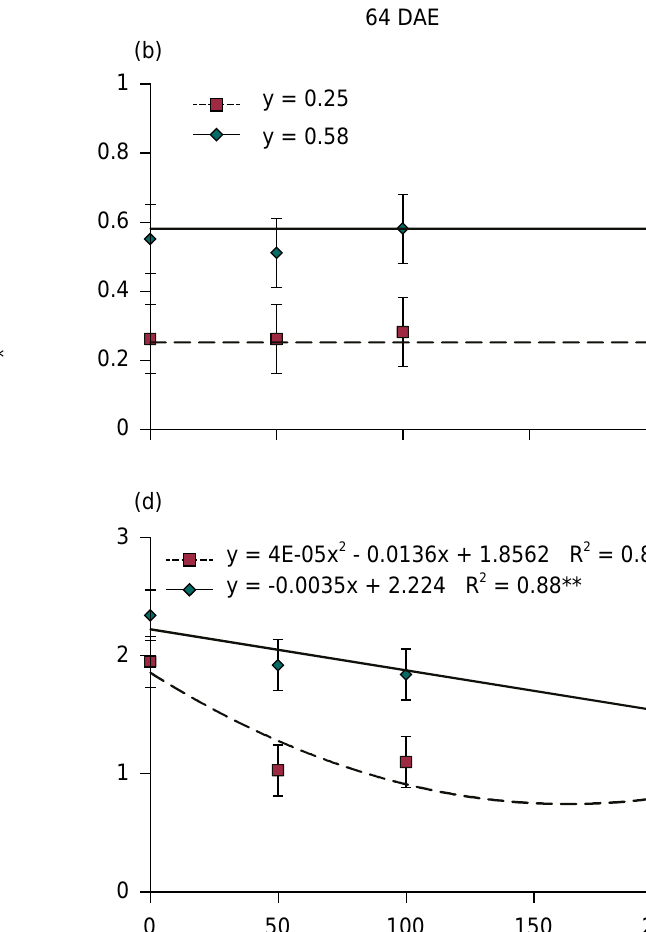
y = -0.0004x 2 + 0.10x + 3.99 R 2 =